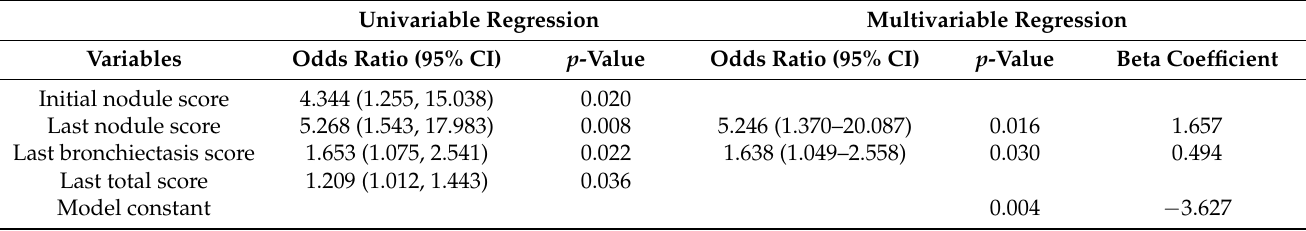
Table 4. Results of logistic regression analysis and predictor